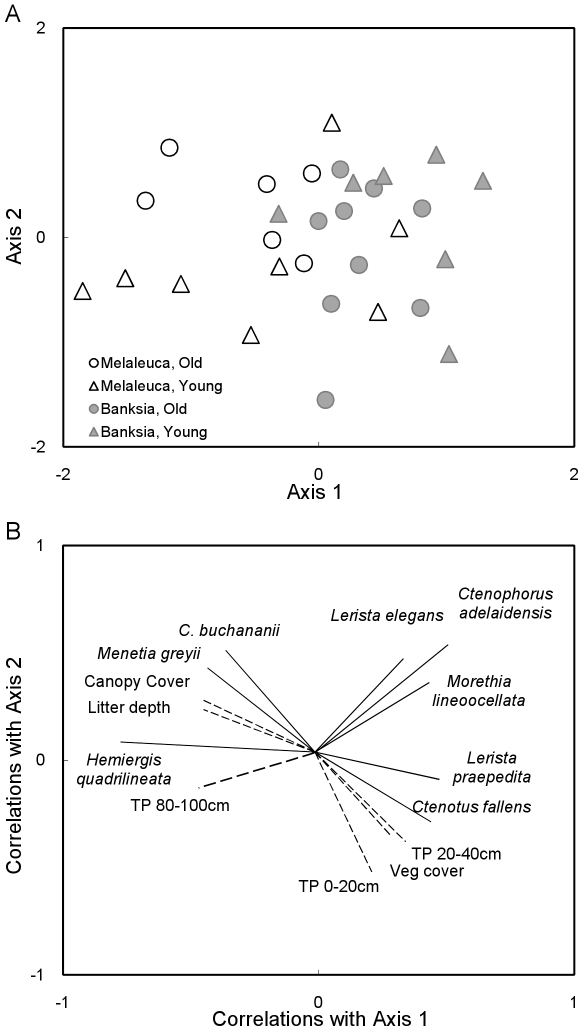
NMDS ordination (Sorensen distance measure) on the assemblage of reptiles.a) NMDS ordination of 21 reptile species at 30 sites of differing habitat (melaleuca vs banksia) and fire age (old versus young). The ordination is in two dimensions (stress = 0.193), with axis 1 and 2 cumulatively representing 75% variance (r2 = 0.441 and 0.310 respectively). b) Correlations of species and habitat variables (r2>0.2) with NMDS ordination.